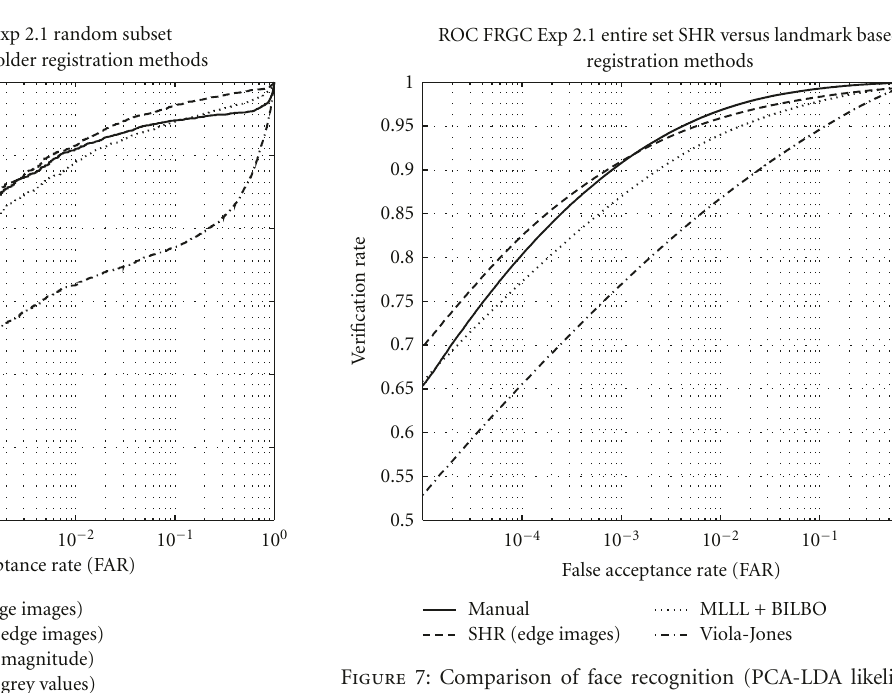
Figure 6: Comparing the e ff ects of our new evaluation criteria and new features, this shows that the Bayesian Framework with edge images achieves the best results.